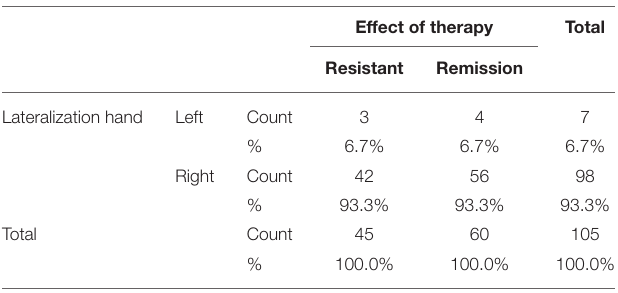
TABLE 1 | Relationship between functional lateralization of the hand and the effectiveness of therapy.